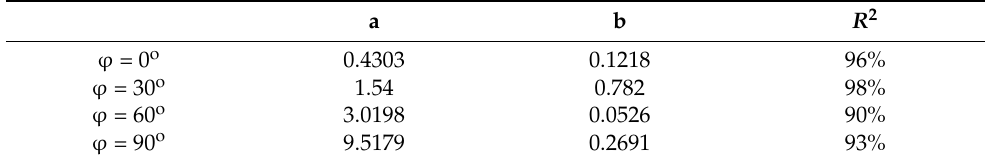
Table 4. Correlation data used for correlation (13) at different tilt